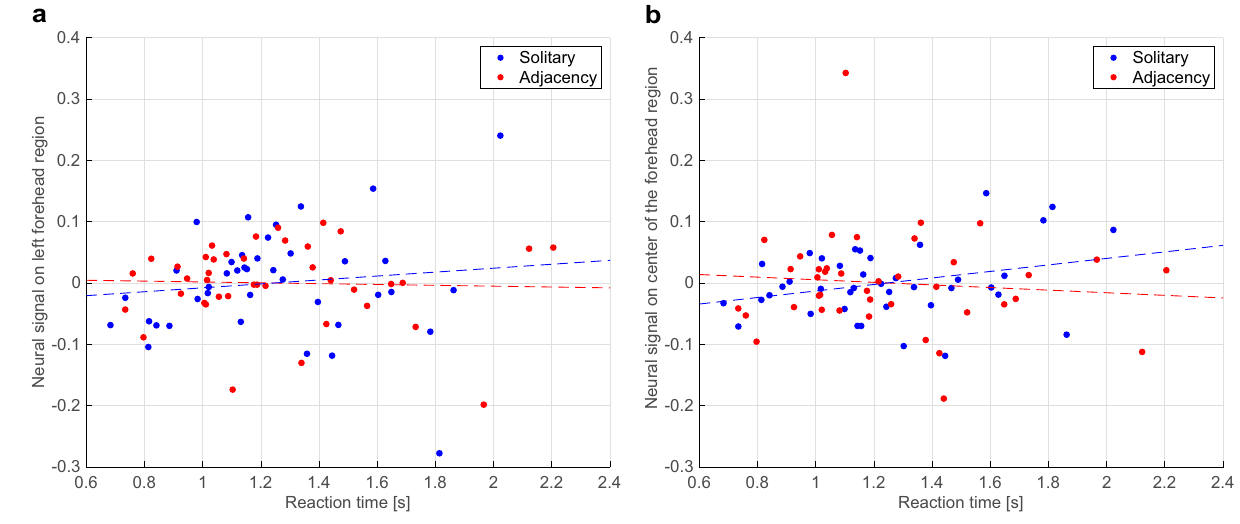
Figure 2. Relationship between reaction time and task-related change in neural signal under each condition for the ( a ) left and ( b ) center of the forehead. Note that the effect of participants’ sex was excluded from the change in each neural signal. The dashed line indicates the regression line. Measurement